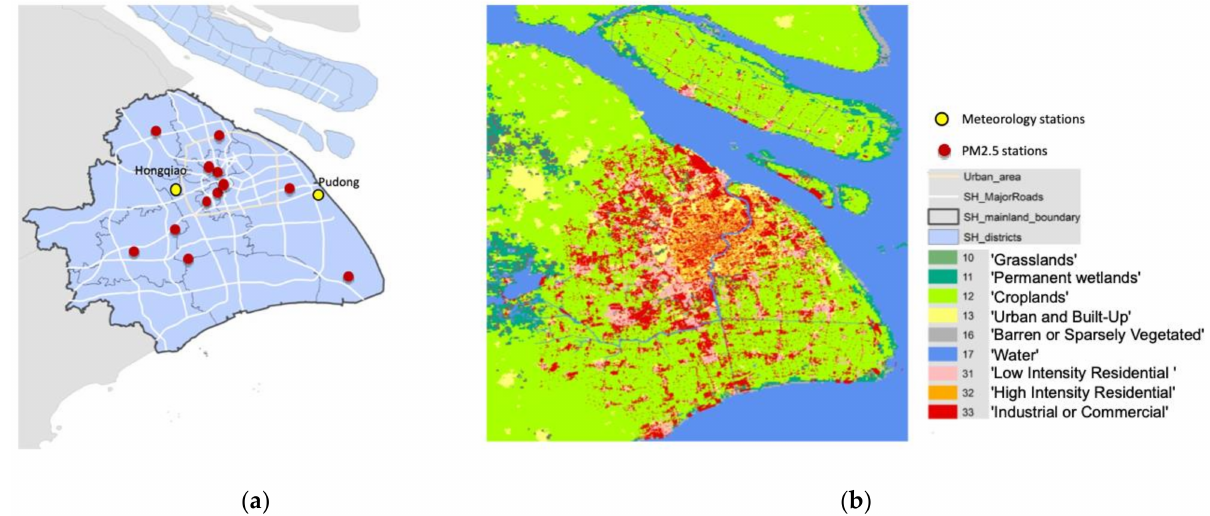
Figure 2. ( a ) Shanghai area map and meteorology/PM2.5 monitor locations; ( b ) 10 base land uses of the city of